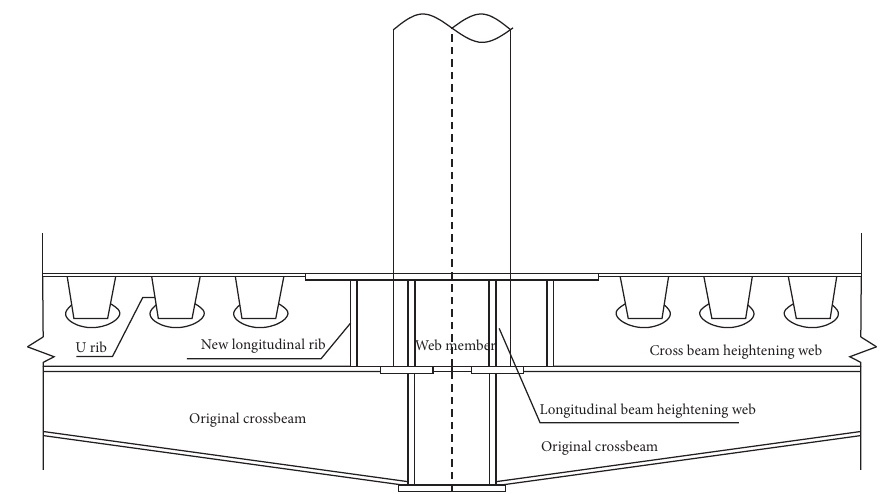
Figure 9: Section diagram of the integral steel deck system.